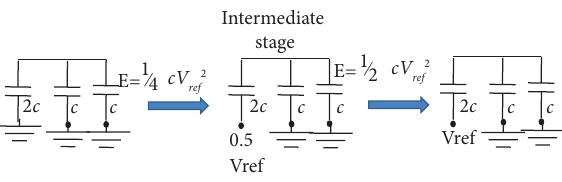
Figure 30: Te two-step switching